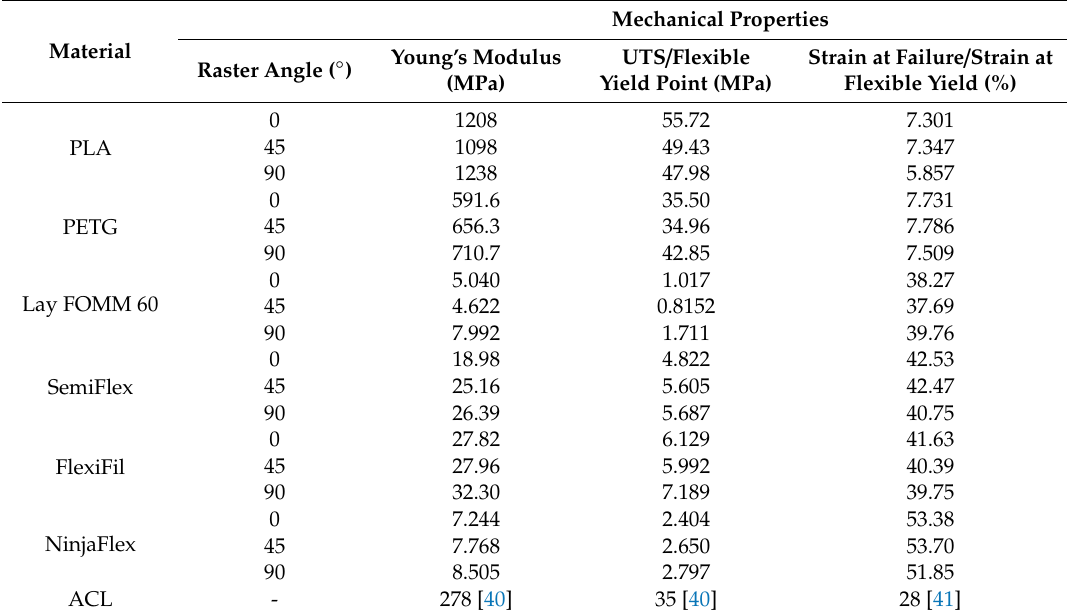
Table 5. Mechanical properties of all specimens and ACL literature